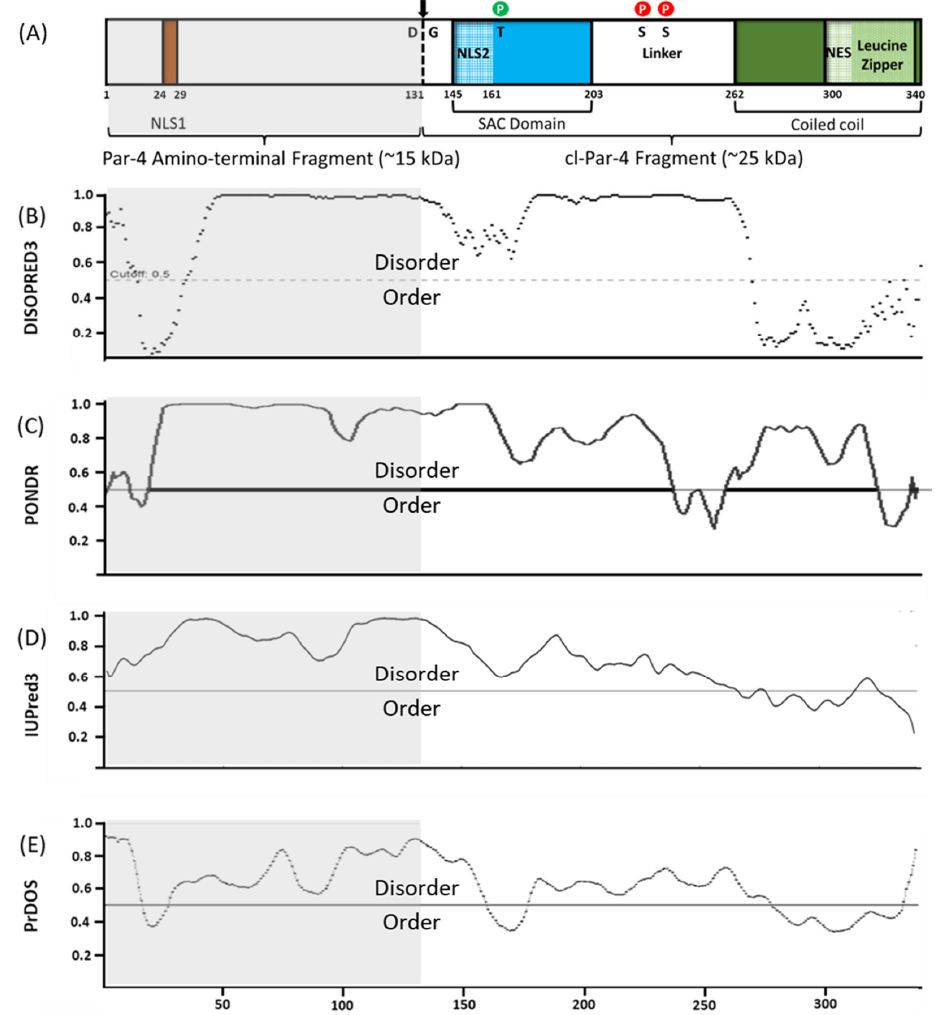
Figure 1. ( A ) Domain diagram of full-length Par-4 and ( B – E ) disorder prediction of the full-length Par-4 sequence using: ( B ) DISOPRED3 [15,16], ( C ) PONDR [17], ( D ) IUPred3 [18], and ( E ) PrDOS [19].